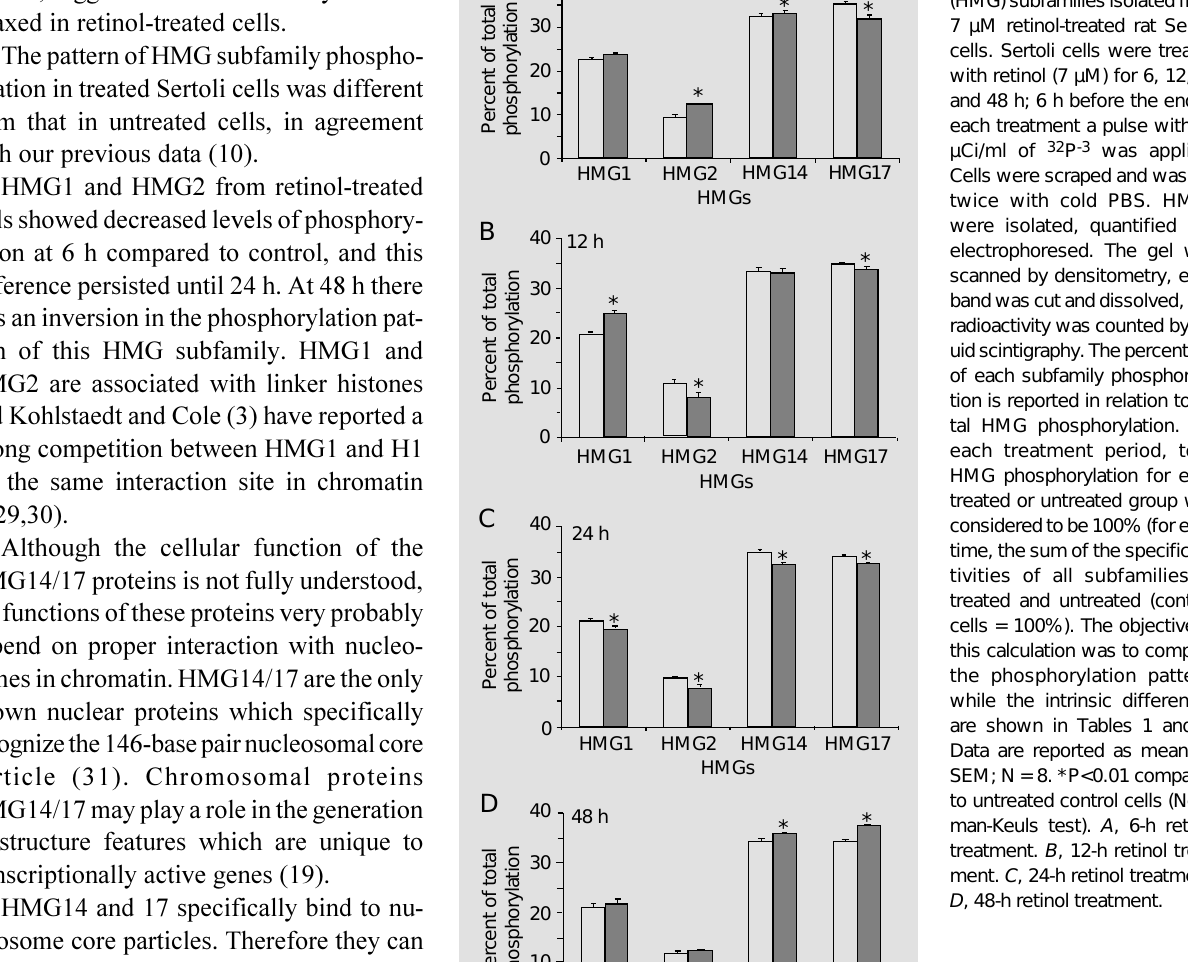
Figure 2 - 32 P -3 incorporation into high mobility group protein (HMG) subfamilies isolated from 7 µM retinol-treated rat Sertoli cells. Sertoli cells were treated with retinol (7 µM) for 6, 12, 24 and 48 h; 6 h before the end of each treatment a pulse with 10 µCi/ml of 32 P -3 was applied. Cells were scraped and washed twice with cold PBS. HMGs were isolated, quantified and electrophoresed. The gel was scanned by densitometry, each band was cut and dissolved, and radioactivity was counted by liq- uid scintigraphy. The percentage of each subfamily phosphoryla- tion is reported in relation to to- tal HMG phosphorylation. For each treatment period, total HMG phosphorylation for each treated or untreated group was considered to be 100% (for each time, the sum of the specific ac- tivities of all subfamilies of treated and untreated (control) cells = 100%). The objective of this calculation was to compare the phosphorylation pattern, while the intrinsic differences are shown in Tables 1 and 2. Data are reported as means ± SEM; N = 8. *P<0.01